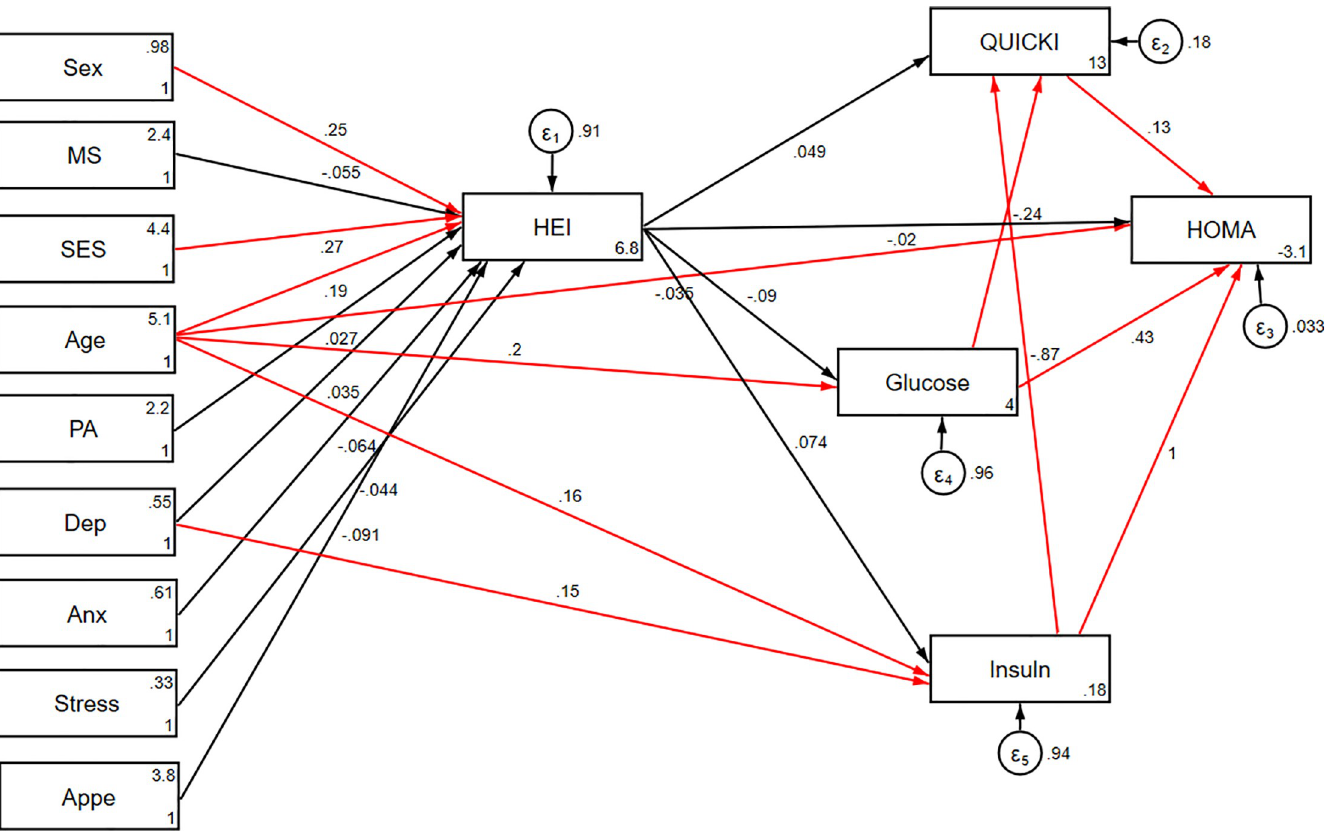
Fig 4. Path analysis diagram with standardized estimates illustrating the total effects of socio-demographic and psychological parameters and diet on insulin resistance indices. Abbreviations: HEI, healthy eating index; HOMA, homeostasis model assessment; QUICKI, quantitative insulin sensitivity check index; SES, socio- economic status; PA, Physical activity; MS, marital status; Anx, anxiety; Dep, depression; Appe, appetite. � All path coefficients are standardized. Red arrows mean p. value � 0.05. £ Total effect is defined as the sum of direct and indirect effects.